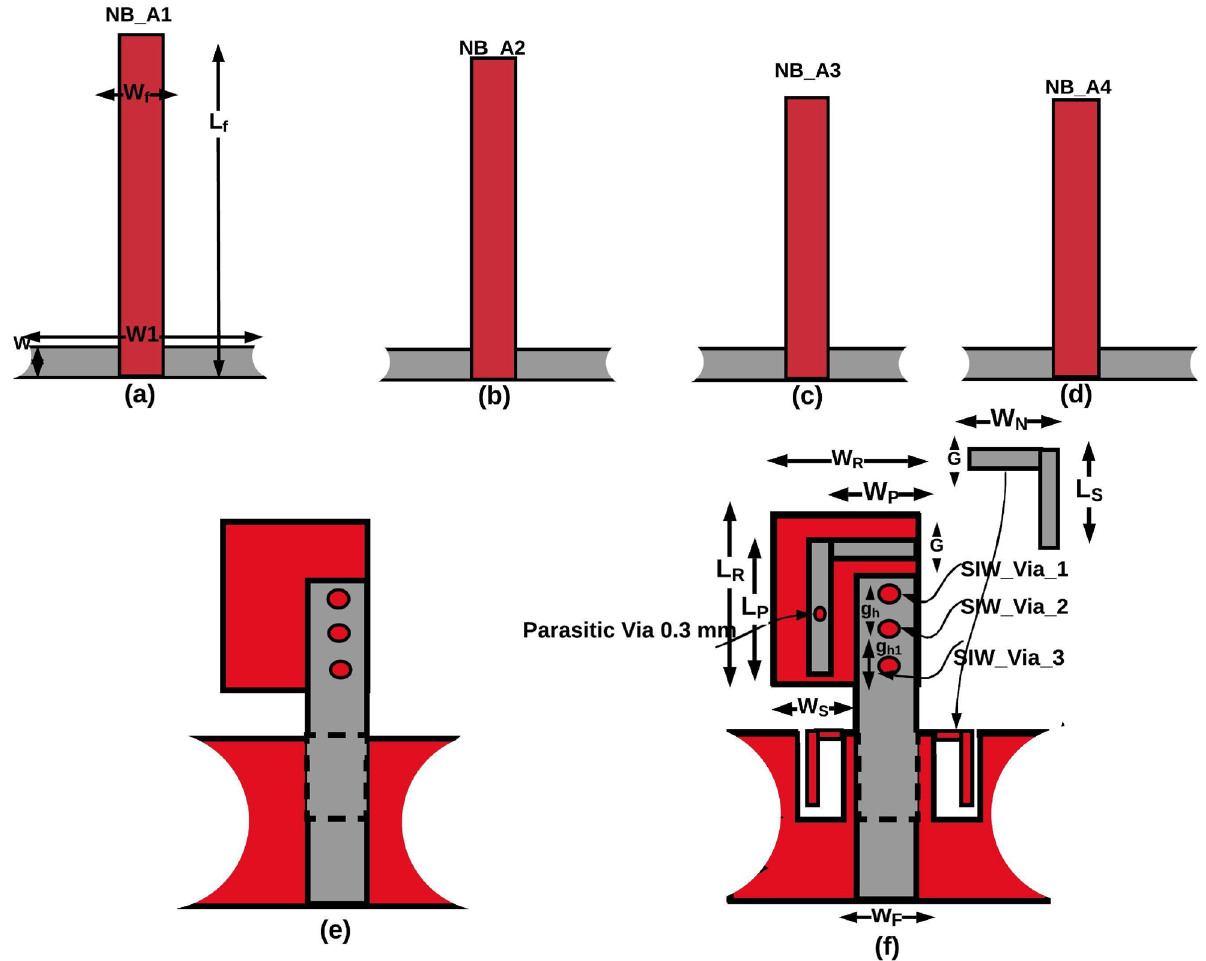
Figure 2. ( a )–( d ) Narrow band antennas, ( e ) Substrate Integrated Wave guide (SIW) based UWB antenna, ( f ) Substrate Integrated Waveguide (SIW) based dual band notch UWB